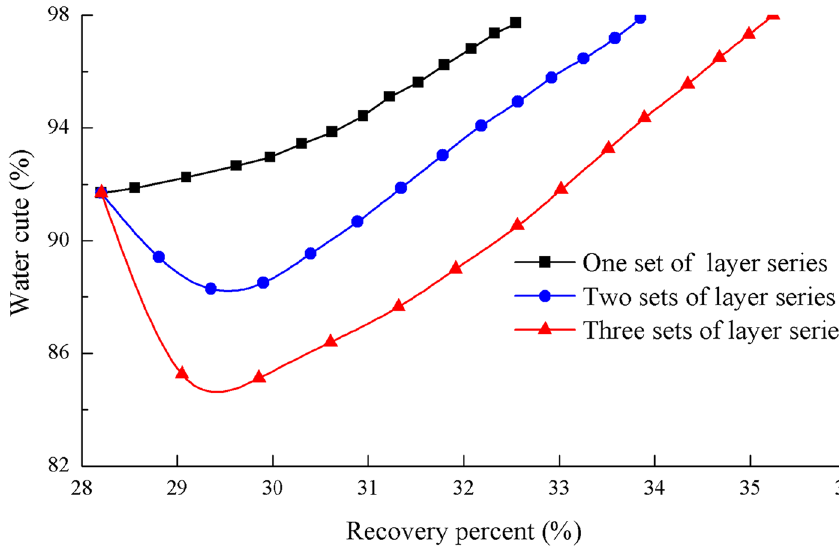
Fig. 10 Curves of water cut and recovery percent of